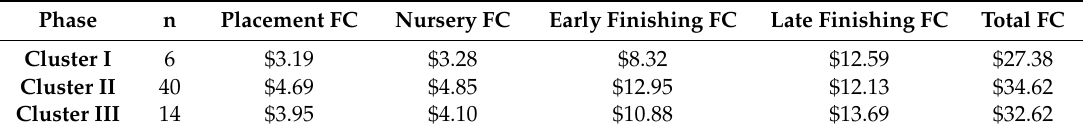
Table 8. Feed cost per pig (FC / P) was determined by phase for each cluster. Then model calculated profit / loss with these values (Table 8). Cluster II had the highest FC / P in each phase; cluster I showed the lowest cost per pig in each phase; cluster III was in between.